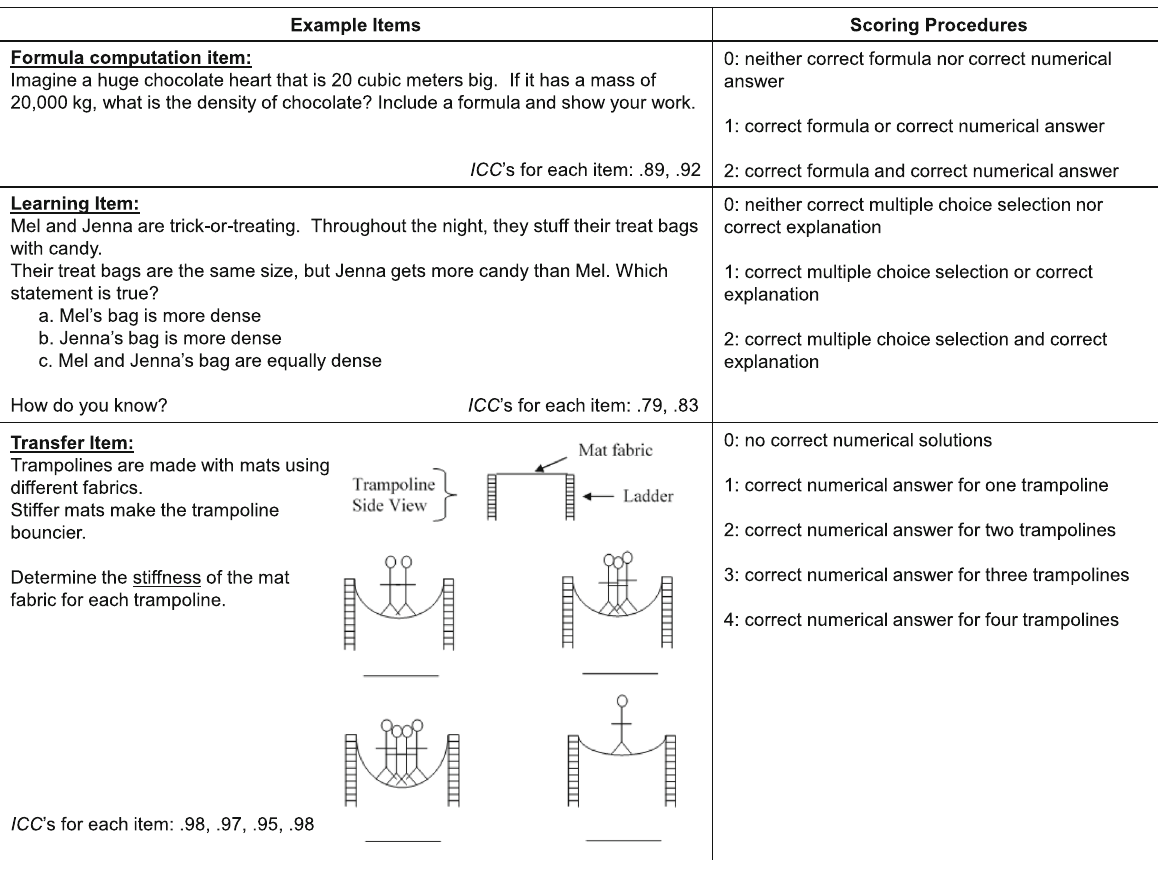
Fig. 3 Example test questions and scoring. Transfer items were adapted from Schwartz et al.